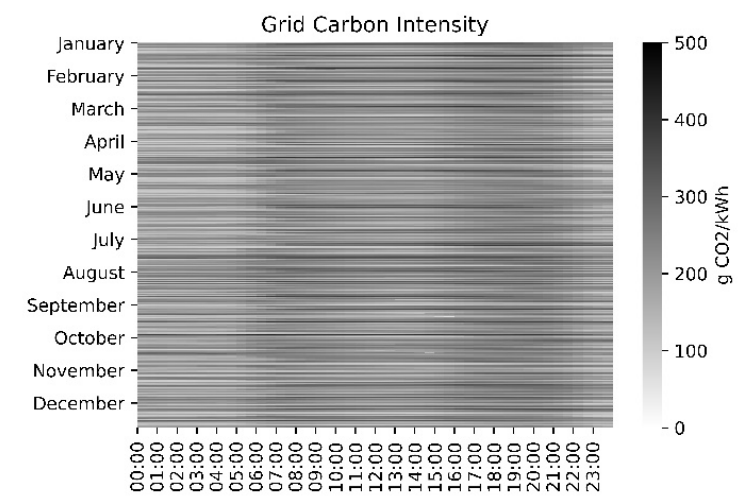
and 09:00 h and between 16:00 and 20:00 h.